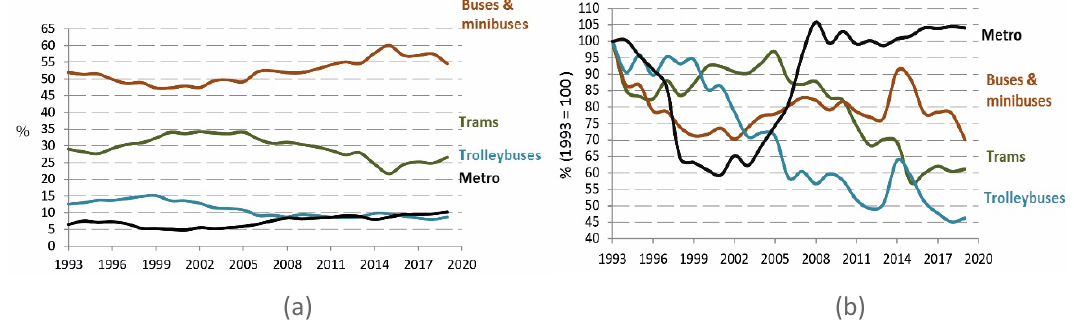
Figure 4: (a) Evolution of modal split of urban public transport in Romania (own elaboration, according to data from INSSE, 2020a); (b) Evolution of the number of passengers transported